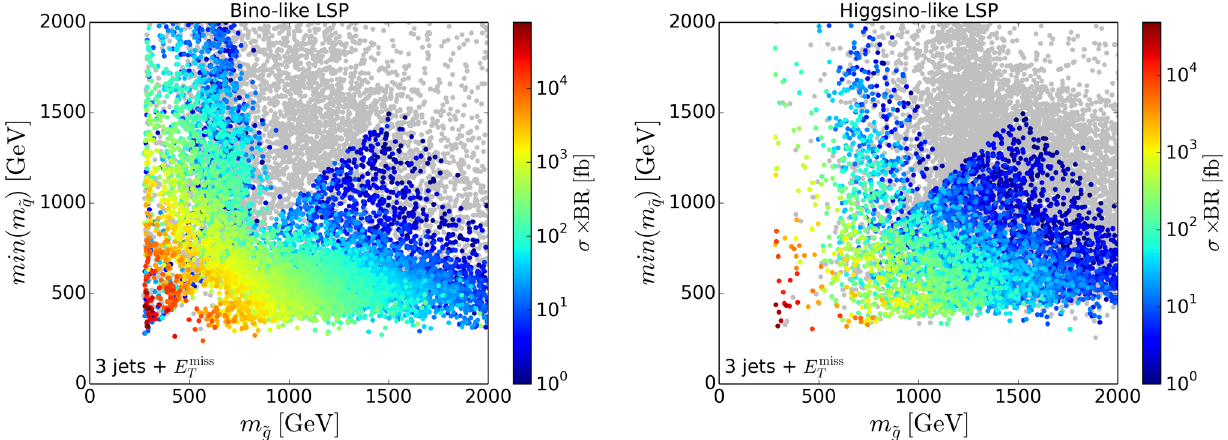
Fig. 6 Cross section for the ˜ g ˜ q → 3 jets + E miss